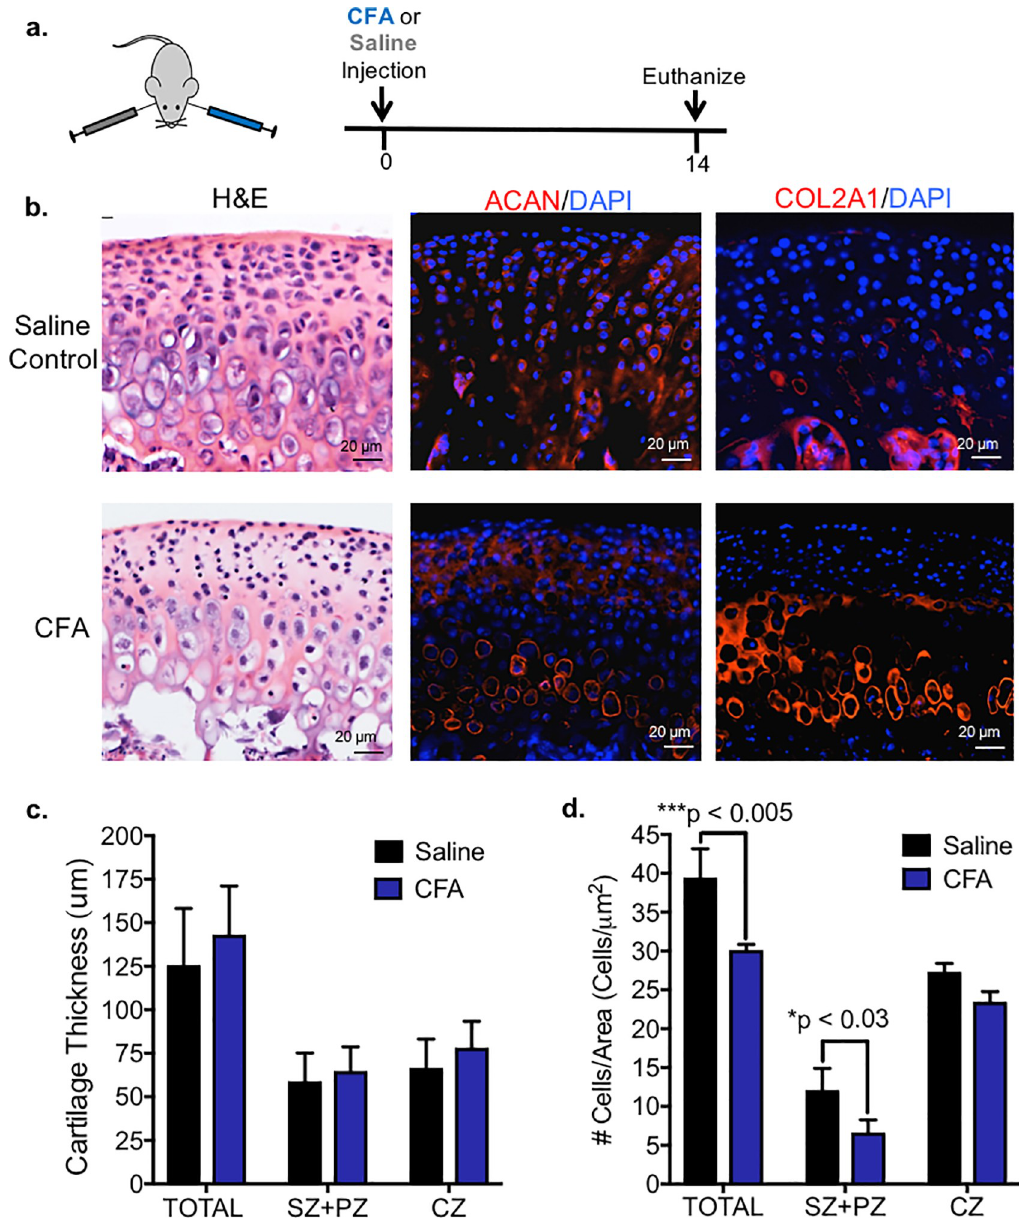
Fig 6. TMJ intra-articular injections of CFA promotes cell depletion in mandibular condyles. (a) CFA was injected intra- articularly into the TMJ unilaterally, while vehicle control was injected onto the contralateral TMJ (n = 4 mice). (b) Representative and comparable histological sections from TMJs were stained with H&E. Immunohistochemistry (red) showed increase in aggrecan (ACAN) and type II collagen (COL2a1) expression in condyles treated with CFA. Isotype-matched negative control antibodies were used under the same conditions. (c) TMJs treated with CFA had no change in cartilage thickness within all cellular zone (TOTAL), chondrocyte zone (CZ) as indicated by COL2a1+ expression, nor superficial zone and polymorphic zone (SZ+PZ) as indicated by COL2a1 - expression, relative to vehicle control explants. Data are mean ± SD; n = 4 mice; two-way ANOVA followed by Tukey’s post hoc. (d) TMJs treated with CFA had significantly decreased number of cells within total cartilage due to loss of cells in the superficial zone and polymorphic zones (SZ+PZ), as indicated by COL2a1 - expression relative to contralateral TMJs. Data are mean ± SD; n = 4 mice; two-way ANOVA followed by Tukey’s post